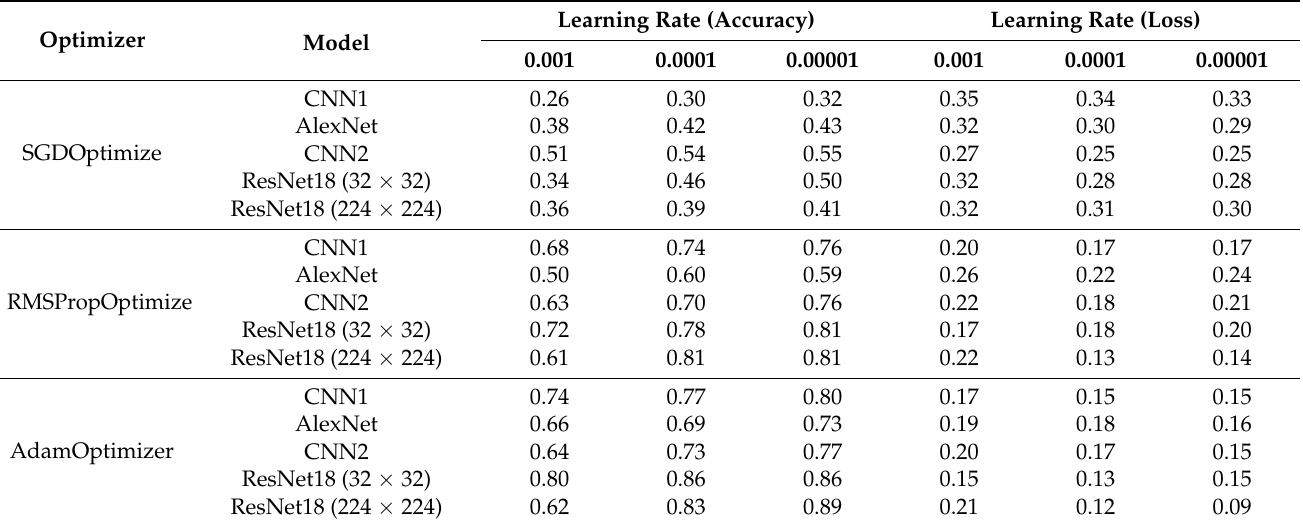
Table 3. Effect of different optimizers on